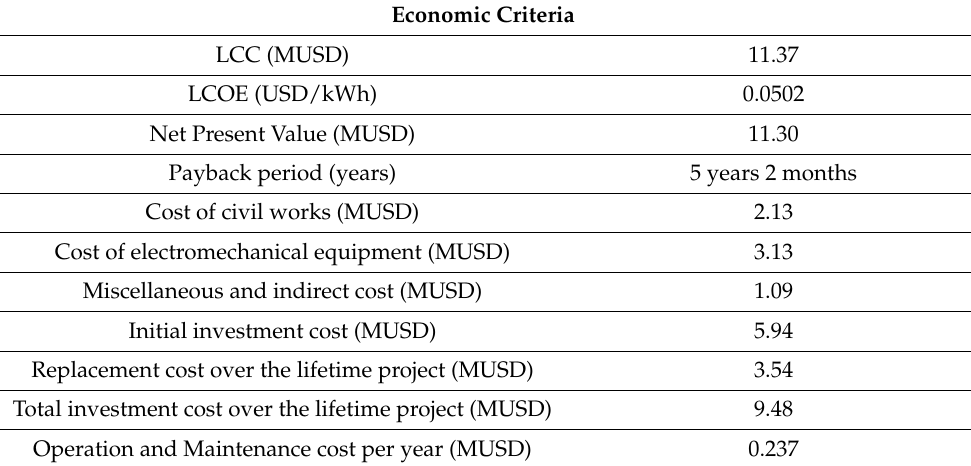
Table 15. Economic